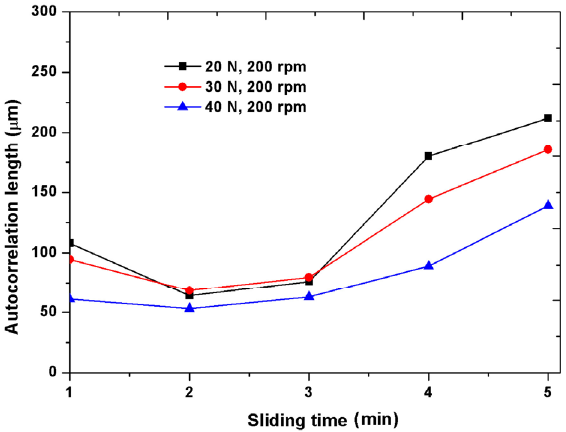
Fig. 20 Variation of S al with sliding time for the same speed and different